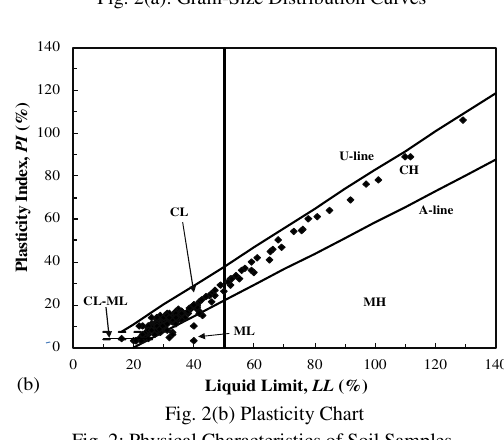
Fig. 2(a): Grain-Size Distribution Curves